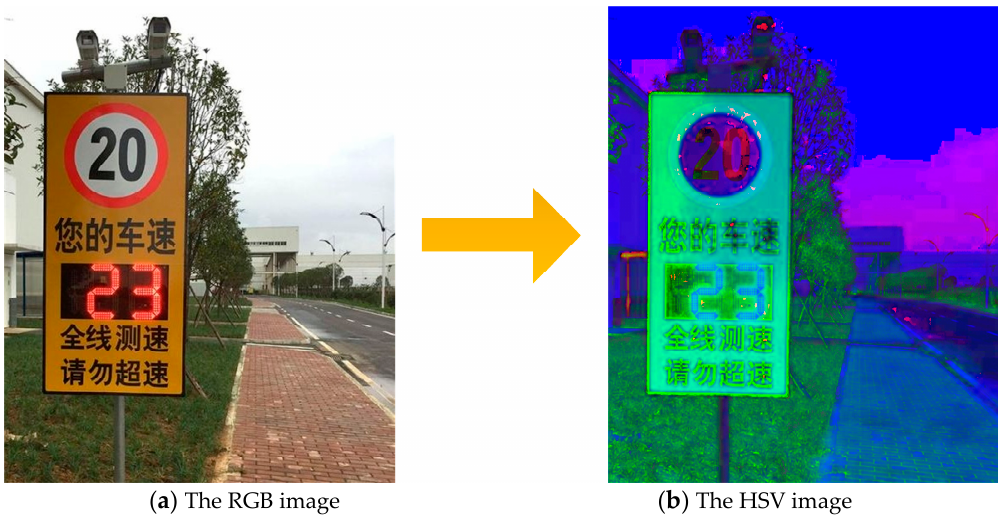
Figure 2. Converting the RGB image to the HSV image.